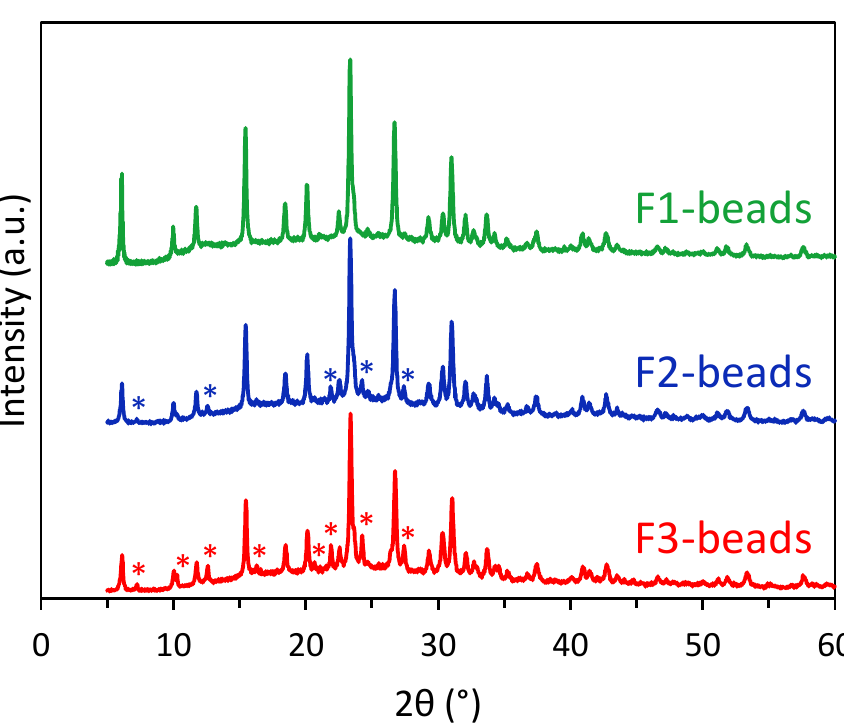
Figure 3. XRD patterns of F1-beads, F2-beads, and F3-beads. Peaks indicated with an asterisk correspond to zeolite with LTA framework (in F2-beads and F3-beads). All the other peaks correspond to zeolite with FAU